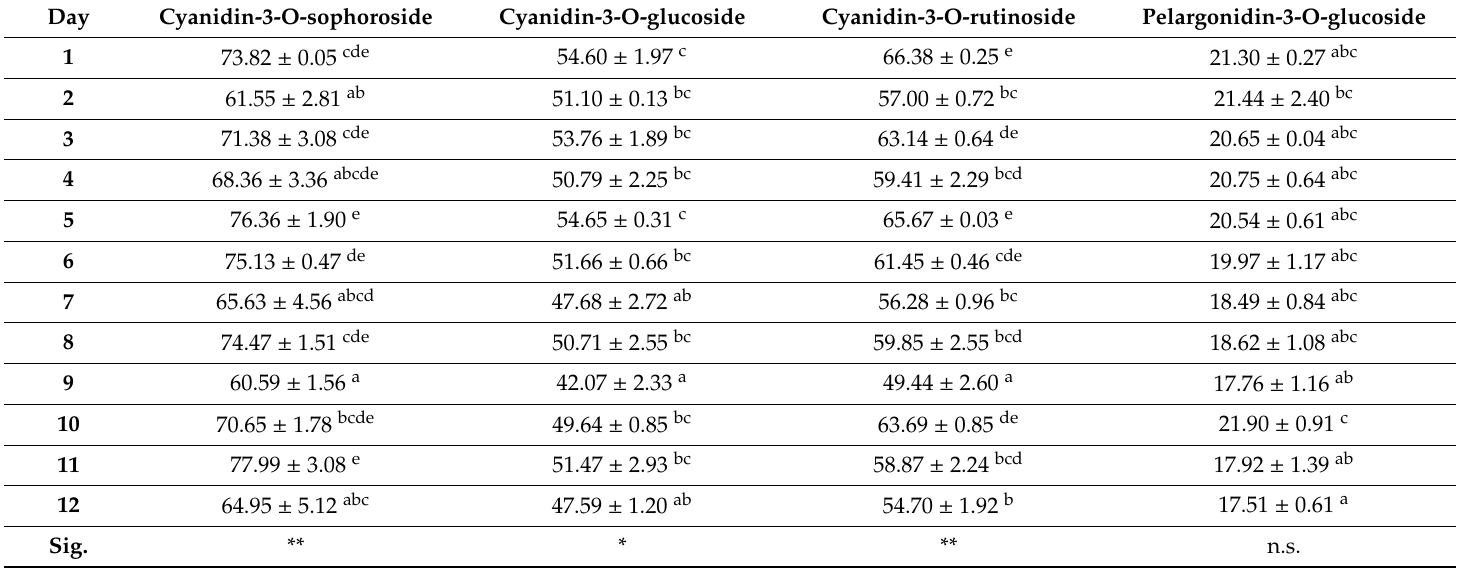
Table 16. Fruits stored at 1 ◦ C in fridge, packaged in PET film. E ff ect of storage period on the di ff erent anthocyanidin compounds content in red raspberries (cv. Erika). Results are expressed in µ g / g of fresh weight. The results are the mean of three replicates ± Standard Deviation. ** ( P ≤ 0.01); * ( P ≤ 0.05); n.s. (not significant). The letters represent the significant di ff erence vertically at P ≤